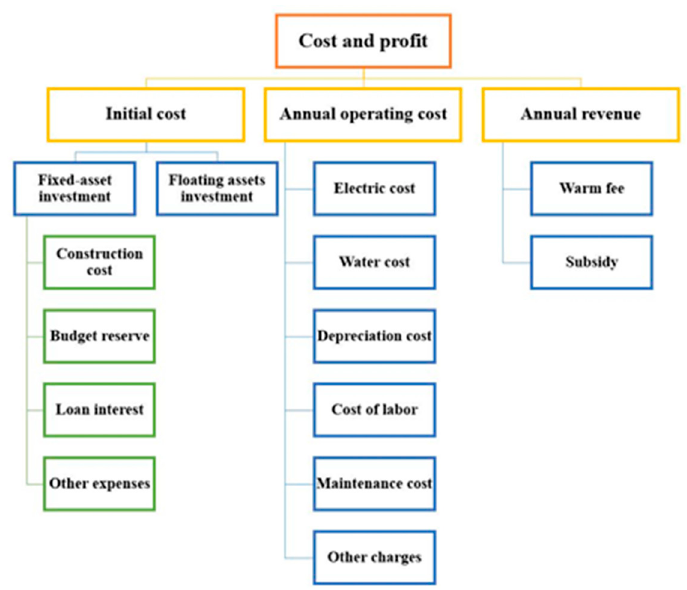
Figure 3. Initial investment, annual operating cost, and revenue of geothermal heating systems.